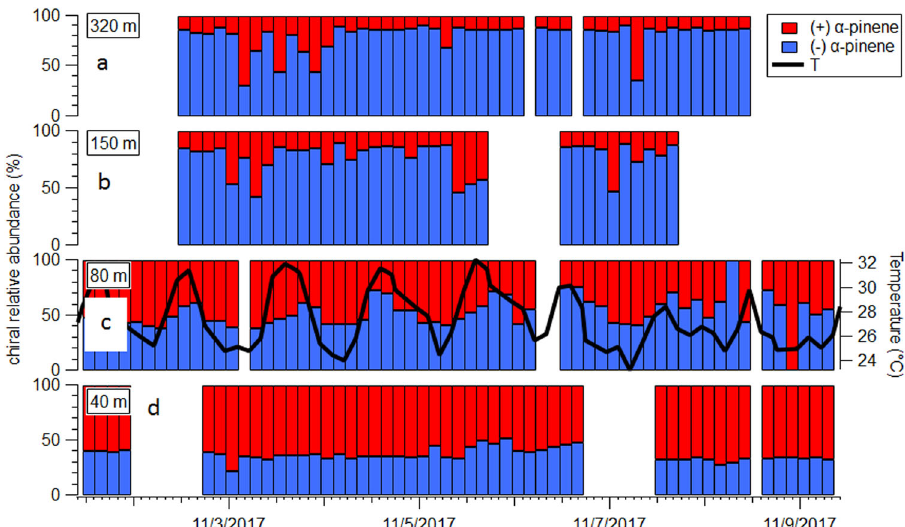
Fig. 4 Relative percentage of ( − )- α -pinene and ( + )- α -pinene air mixing ratios measured at 40, 80, 150, and 320 m up the ATTO tower during the dry season in 2017. Each bar corresponds to a sample collected from the tower. Temperature is measured at 80 m on the neighboring INSTANT tower. Diel pro fi le of the chiral ratios measured at each height with the standard deviation of the dataset shown in Supplementary Fig. 3.